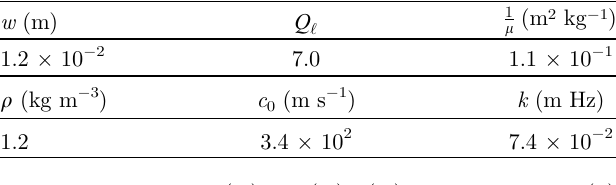
(cid:3) (cid:3) (cid:3)(cid:3) (cid:3) (cid:3) (cid:3) (cid:3) and